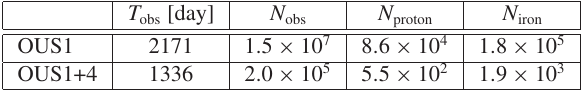
Table 1. The data summary of the OUS1 and OUS4 observations.